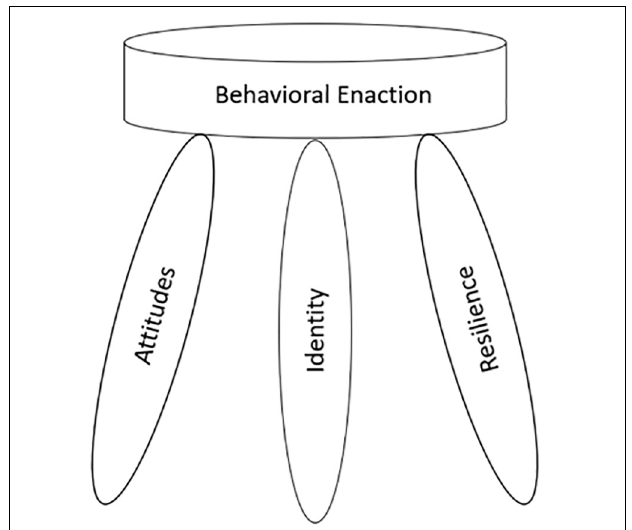
FIGURE 4 | Behavioral enaction. Conceptual representation of the components of behavioral enaction by